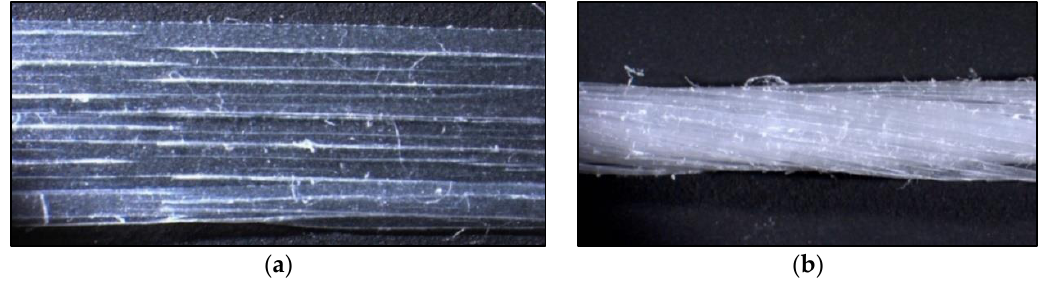
Figure 1. Image of the fibers selected for testing, 10× magnification: ( a ) single fibrillated-tapes polypropylene fiber SFPF (single fibrillated-tapes polypropylene fibers) (400 tex); ( b ) bundle of coiled fibrillated-tapes polypropylene fiber BCFPF (bundles of coiled fibrillated-tapes polypropylene fibers) (2000 tex).